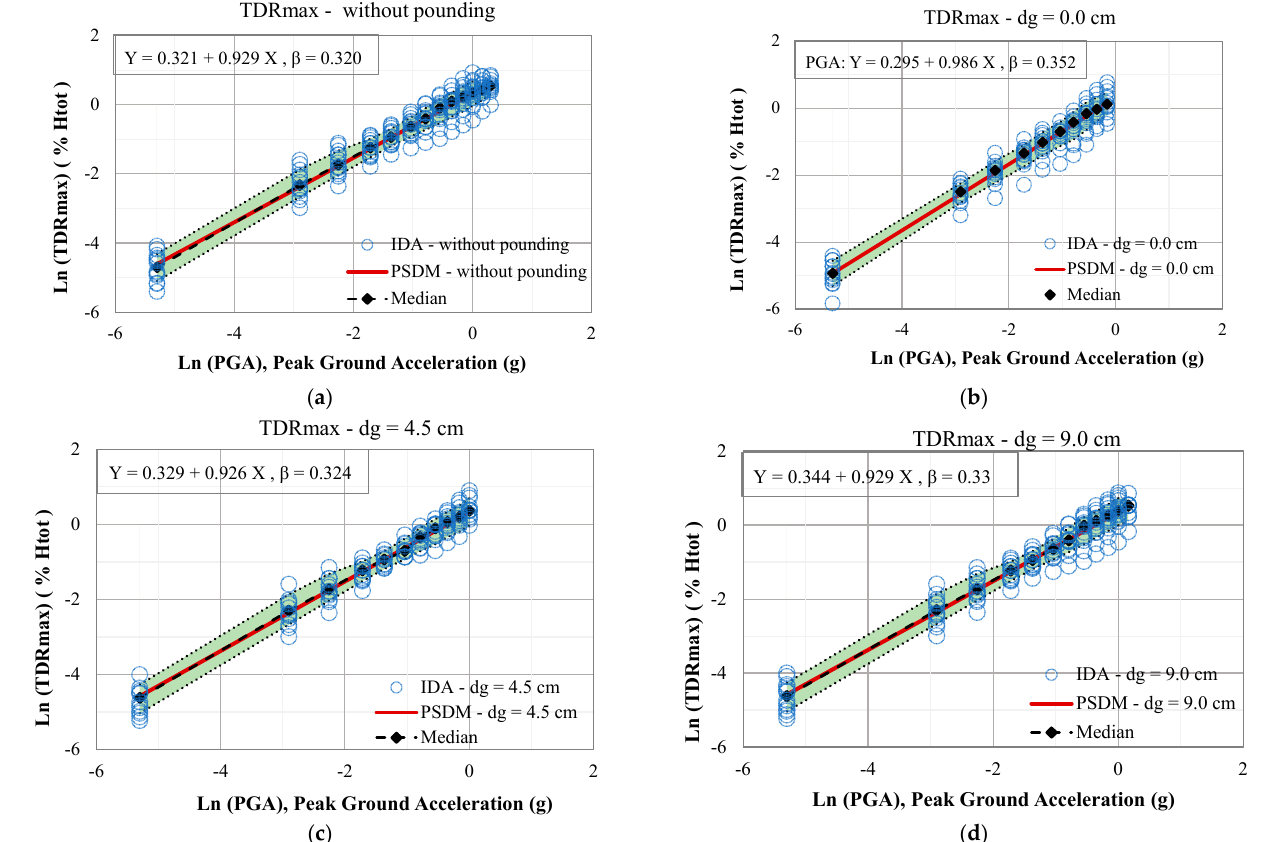
Figure 10. Comparative results in terms of TDR max (%H tot ) at each level of PGA as deduced based on IDAs, PSDMs, and median values of demand. Examined cases: ( a ) without the pounding effect, ( b ) d g = 0.0 cm, ( c ) d g = 4.5 cm, and ( d ) d g = 9.0 cm. In Figure 11, comparative results between linear and bilinear PSDMs of the column C20 in terms of μ φ ,max |PGA are presented. These results are compared with the corresponding median demands at each level of PGA.